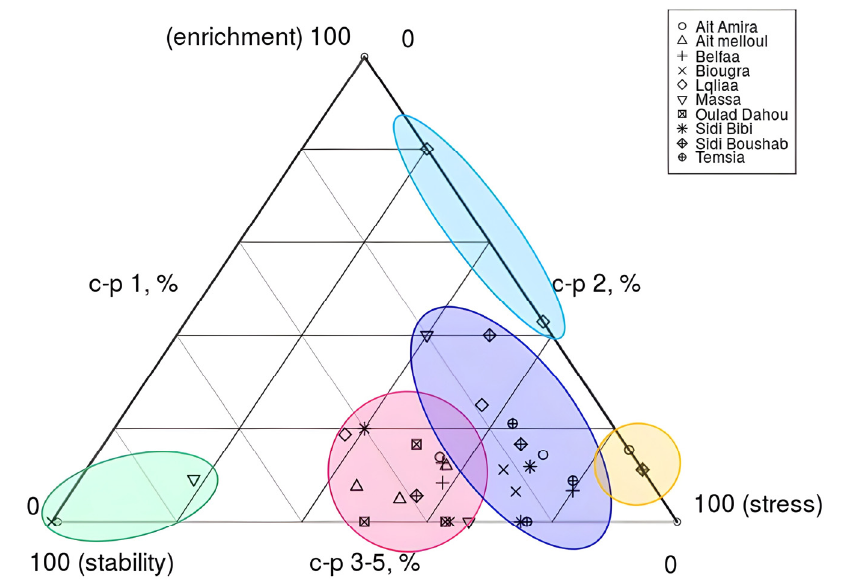
Figure 5. c-p triangle depicting soil status regarding nematodes c-p groups evolution in wheat fields surveyed.